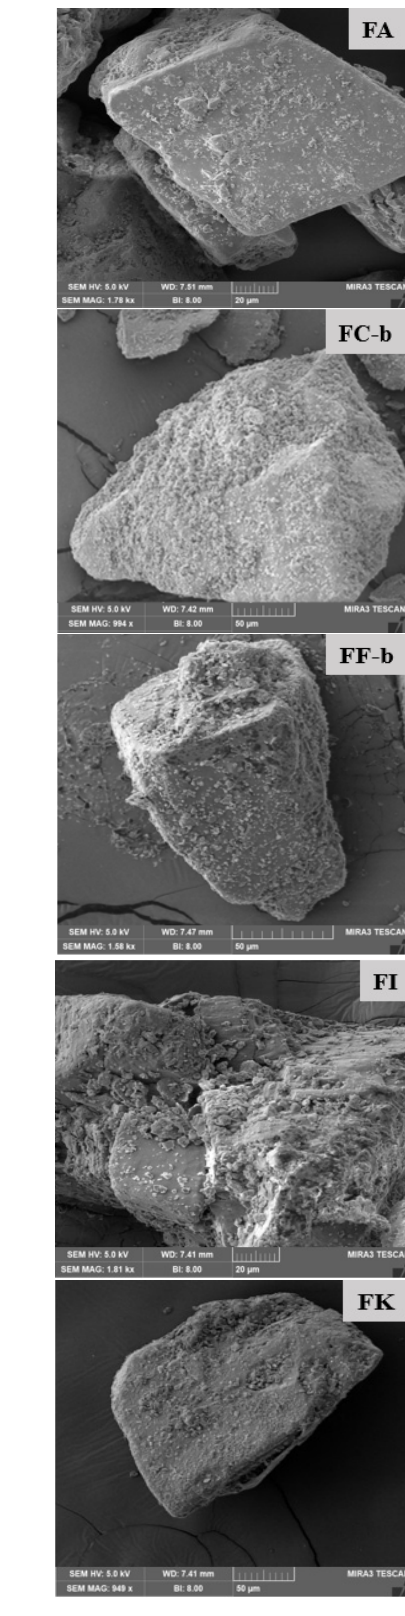
Figure 2. SEM images of original ibuprofen, milled IBF, and developed DPI formulations (FA, FB, FC-a, FC-b, FE, FF-a, FF-b, FG, FH, FI, FD, FJ and FK). FC-a, FC-b, FE, FF-a, FF-b, FG, FH, FI, FD, FJ and